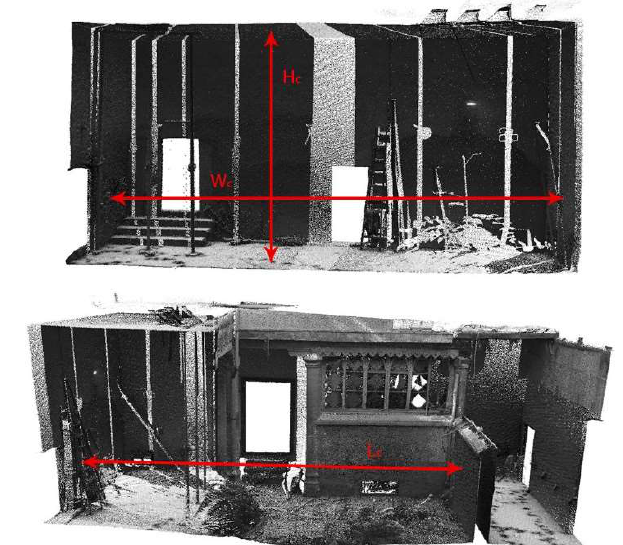
Figure 13. Distances measured for the accuracy evaluation.